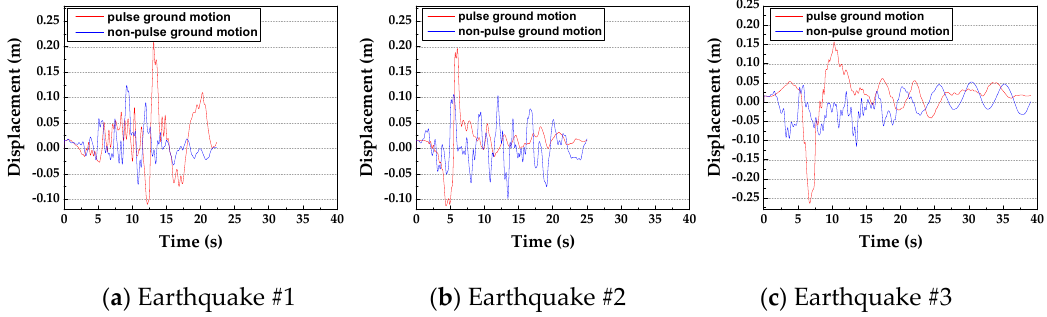
Figure 10. The horizontal displacement of point A with respect to point C (under the input angle of 75°).